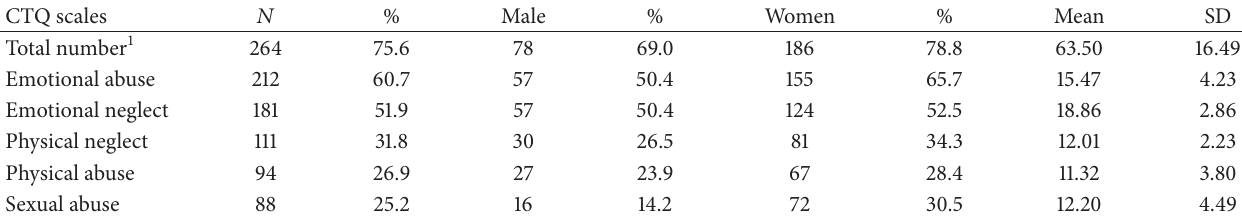
Table 2: Frequencies, means, and standard deviations of depressed patients achieving cutoff scores in CTQ subscales ( 𝑁 = 349 ).